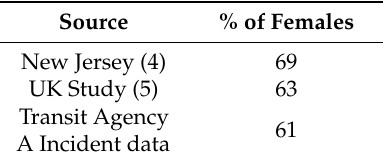
Table 4. Comparison of female involvement in reported injury